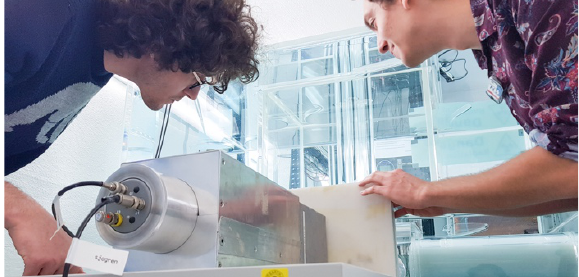
Figure 1: Photograph taken during neutron time-of-flight lab exercise showing students interacting with the setup. Visible are the water-filled tank hosting the radioactive source (background), the neutron detector (foreground) and shielding material being introduced into the neutron